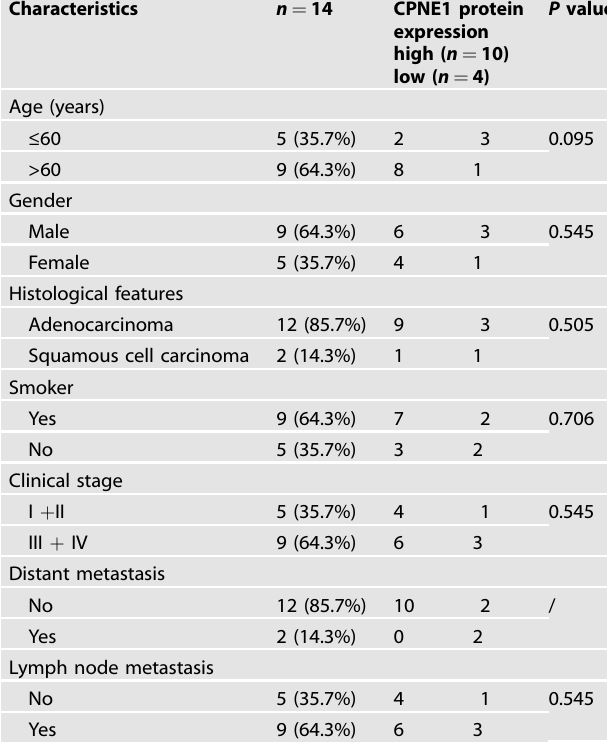
Table 2. Demographic and clinical characteristics of patients and levels of CPNE1 protein expression in NSCLC